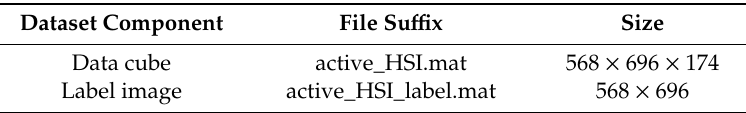
Table 3. An overview of the information about the dataset.